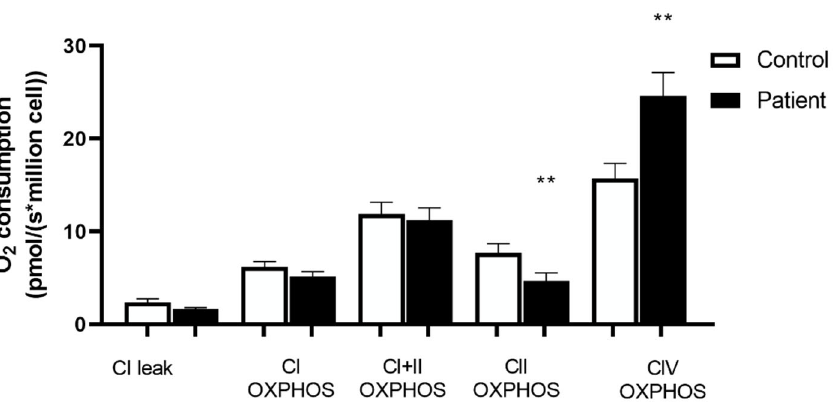
Figure 3. Mitochondrial respiration of Peripheral Blood Mononuclear Cells (PBMCs) in controls and heart transplanted patients. CI: mitochondrial complex I; CI + II: mitochondrial complexes I and II; OXPHOS: mitochondria ADP-activated state of oxidative phosphorylation, CII: mitochondrial complex II. CIV: Mitochondrial complex IV oxidative phosphorylation; Values are means ± SEM, **: p < 0.01, n = 20 per group.